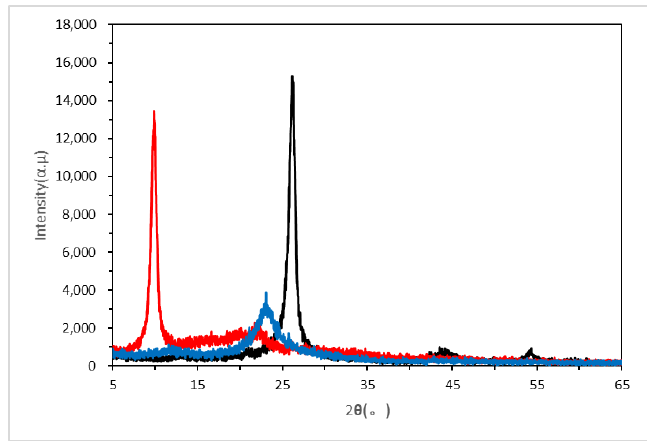
Figure 7. XRD spectrum of the graphite (G), graphene oxide (GO) and activated graphene (JZGO).